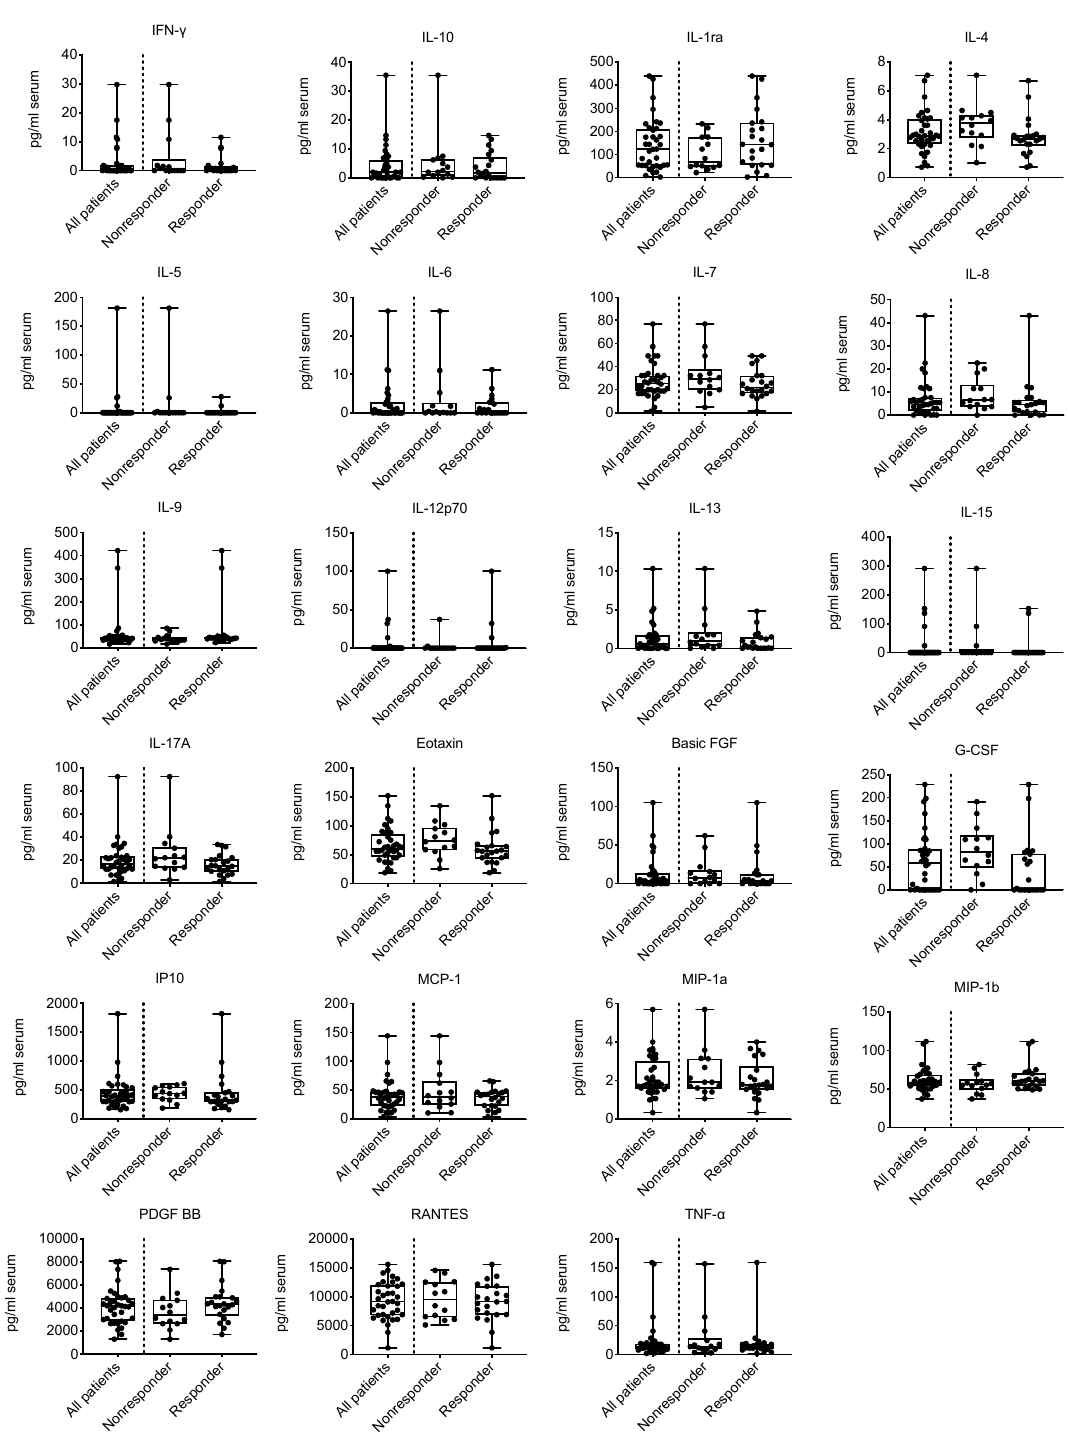
Figure 1. Box and whisker plots representing the preoperative serum cytokine levels in all patients ( n = 36), responders only ( n = 22) and nonresponders only ( n = 14). FGF = fibroblast growth factor. G-CSF = granulocyte colony-stimulating factor. IFN = interferon. IL = interleukin. IP10 = interferon-inducible protein 10. MCP-1 = monocyte chemoattractant protein 1. MIP = macrophage-inflammatory protein. PDGF = platelet-derived growth factor. RANTES = regulated upon activation, normal T cell expressed and secreted. TNF = tumor necrosis factor.